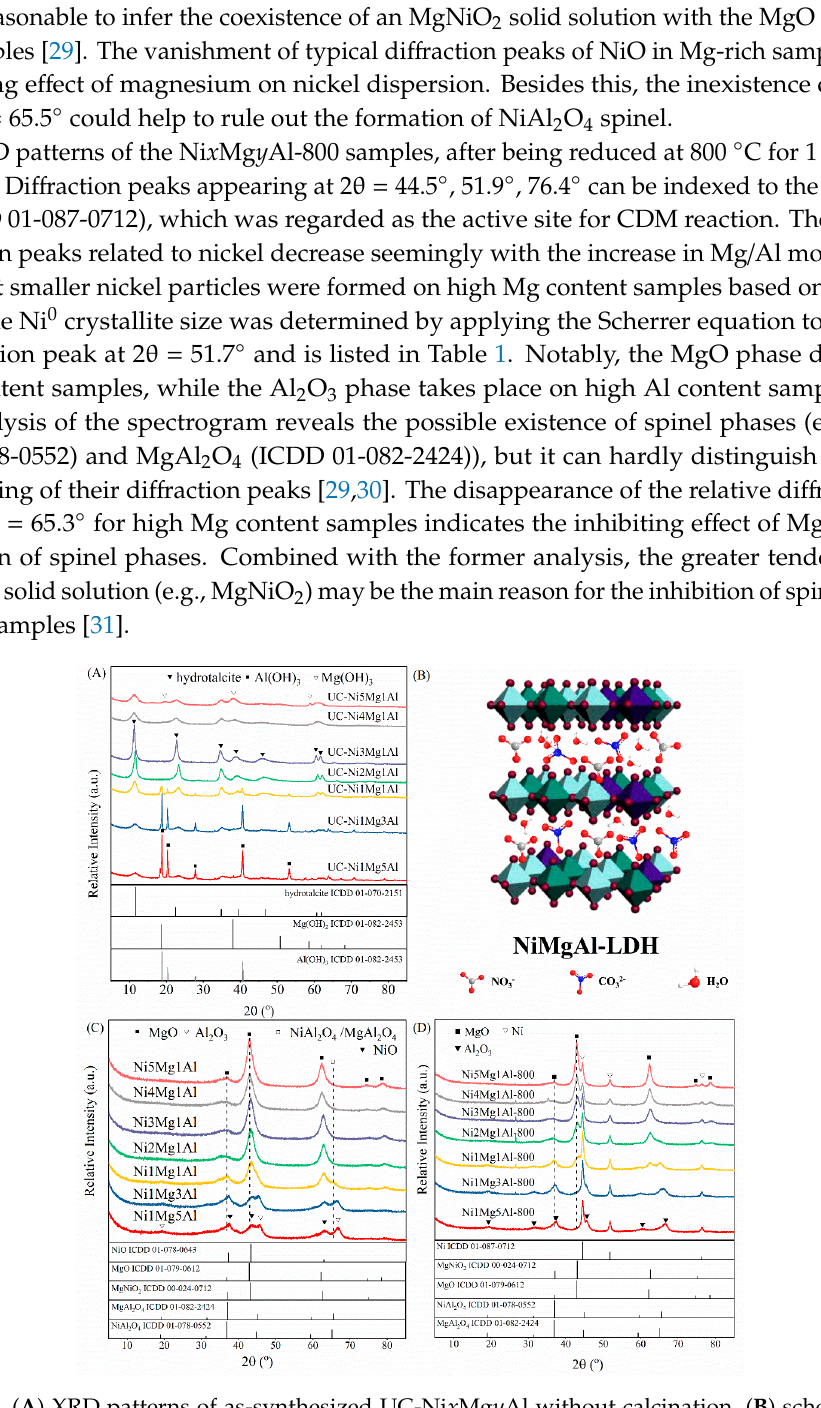
Figure 1. ( A ) XRD patterns of as-synthesized UC-Ni x Mg y Al without calcination, ( B ) schematic of NiMgAl-LDH, ( C ) Ni x Mg y Al samples calcined at 600 °C for 3 h and ( D ) Ni x Mg y Al-800 samples reduced at 800 °C for 1 h.